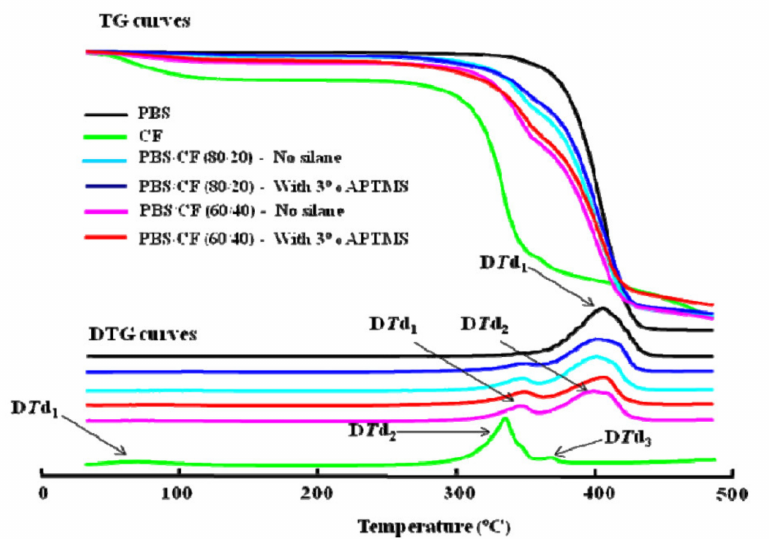
Figure 14. Thermogravimetry (TG) and derivative thermograms (DTG) curves of PBS, chopstick hy- brid fiber (CF), PBS/CF (80/20 wt%), and PBS/CF (60/40 wt%) composites [8]. Adapted with permission from Calabia et al.